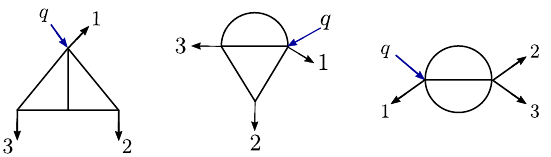
Figure 15 . Examples of topologies with only one valid cut, namely the three-particle cut in the kinematic s 23